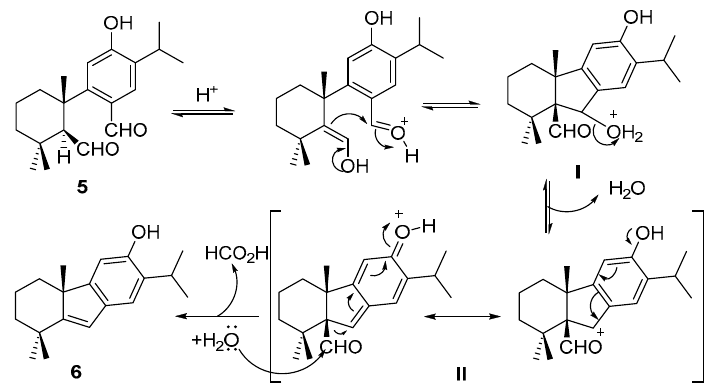
Scheme 3. Mechanism for the transformation of dialdehyde 5 into phenol 6